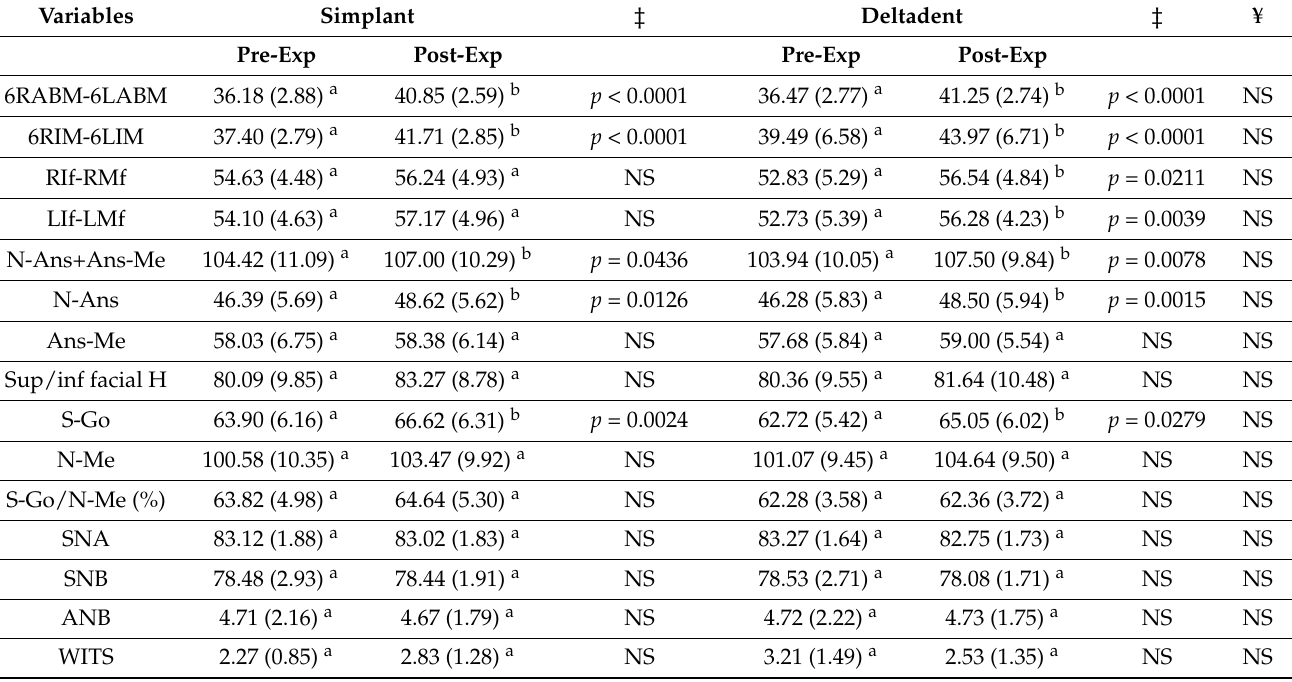
Table 2. Mean values (standard deviation) of the 3D cephalometric analysis from the two